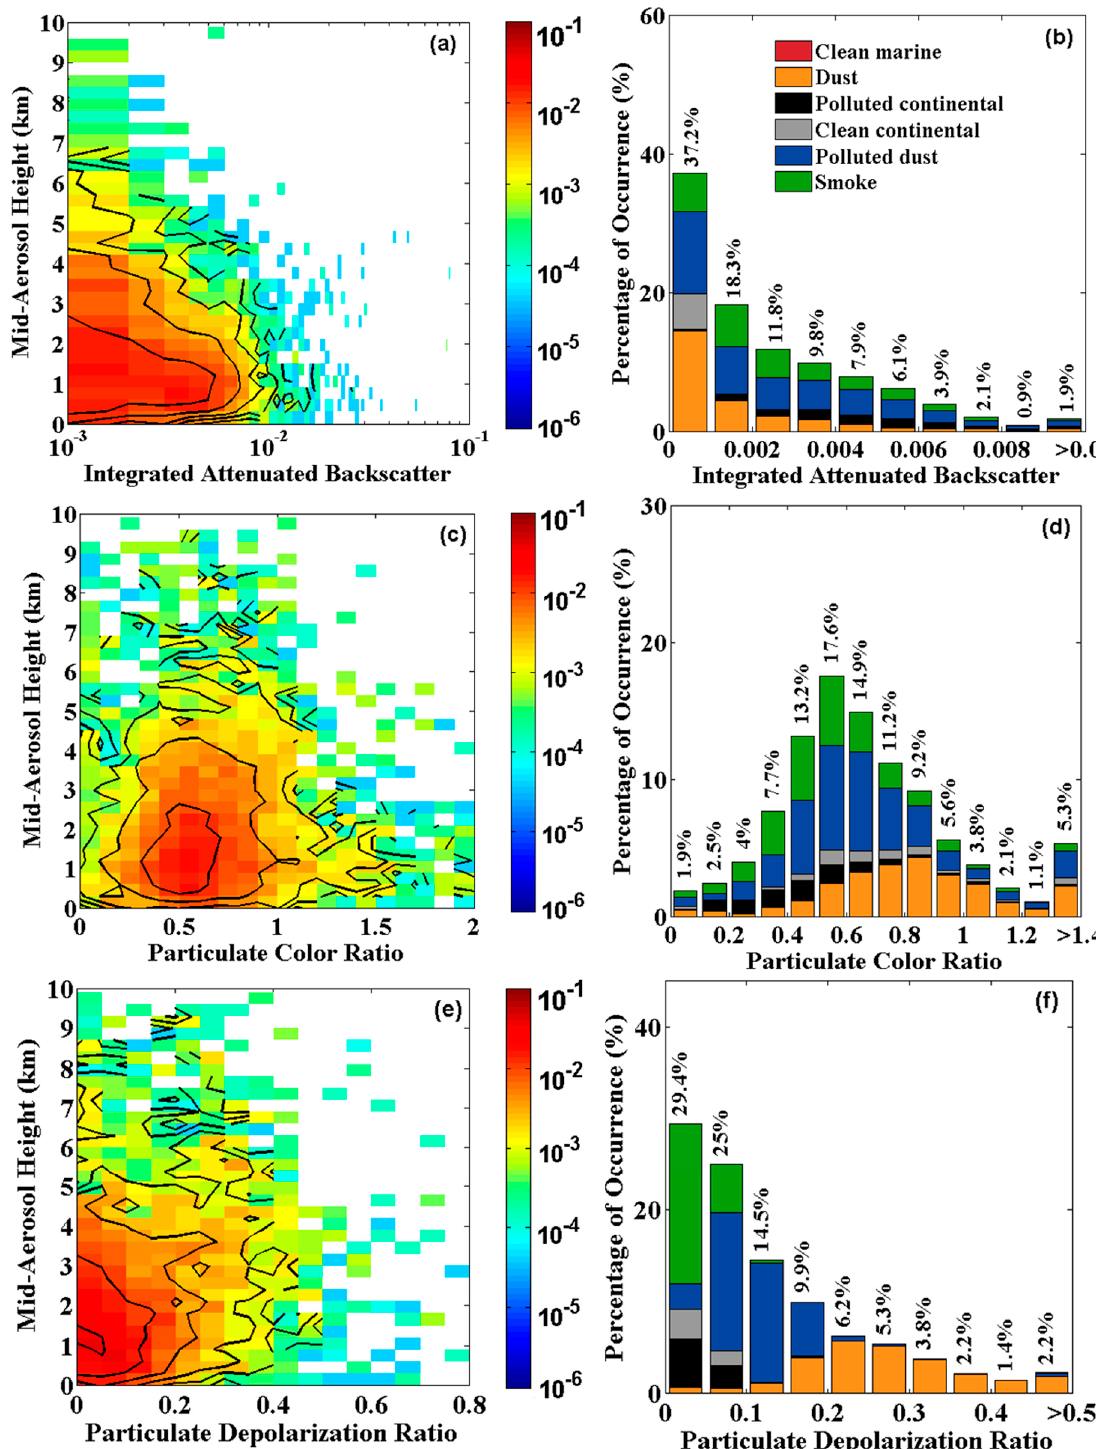
Figure 7. Joint probability distribution of ( a ) integrated attenuated backscatter (IAB), ( c ) color ratio (CR), and ( e ) depolarization ratio (DR) with mid-aerosol height at 0.3-km bin size and the corresponding ( b ) IAB, ( d ) CR, and ( f ) DR probability distribution of each aerosol type over central China from March 2007 to February 2016. The black solid line indicates the joint probability contour plots.